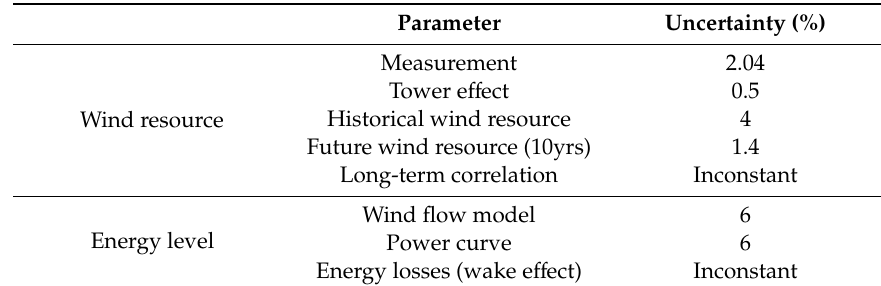
Table 11. Uncertainties associated with parameters [33].